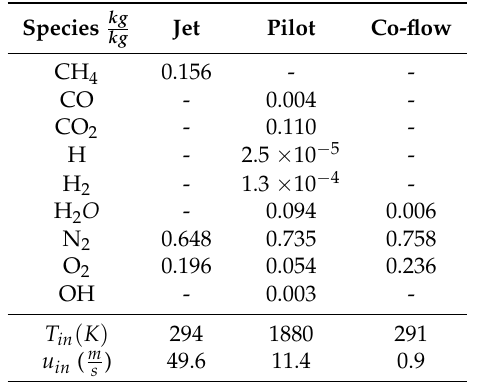
Table 3. Species mass fractions, temperatures and velocities of the jet, pilot, and co-flow of Sandia Flame D